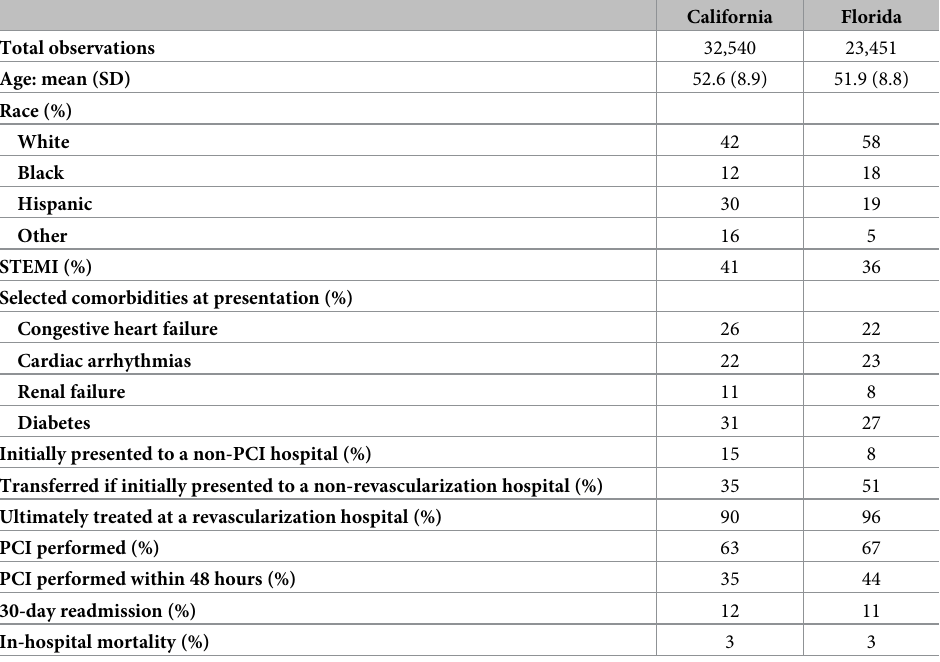
Table 1. Summary statistics of patient characteristics by